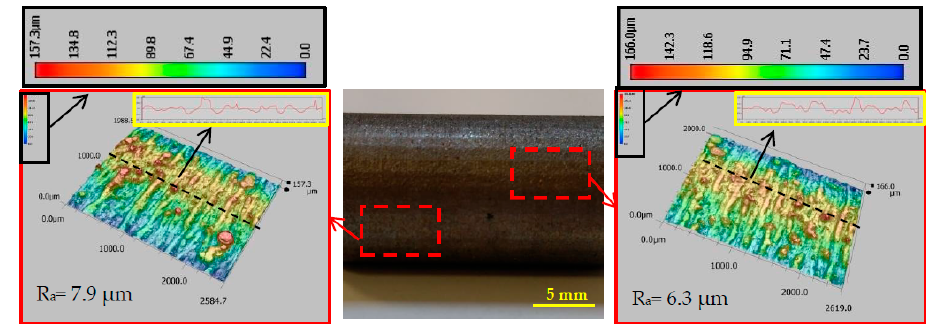
Figure 6. Surface topography of an as-built SLMed part.